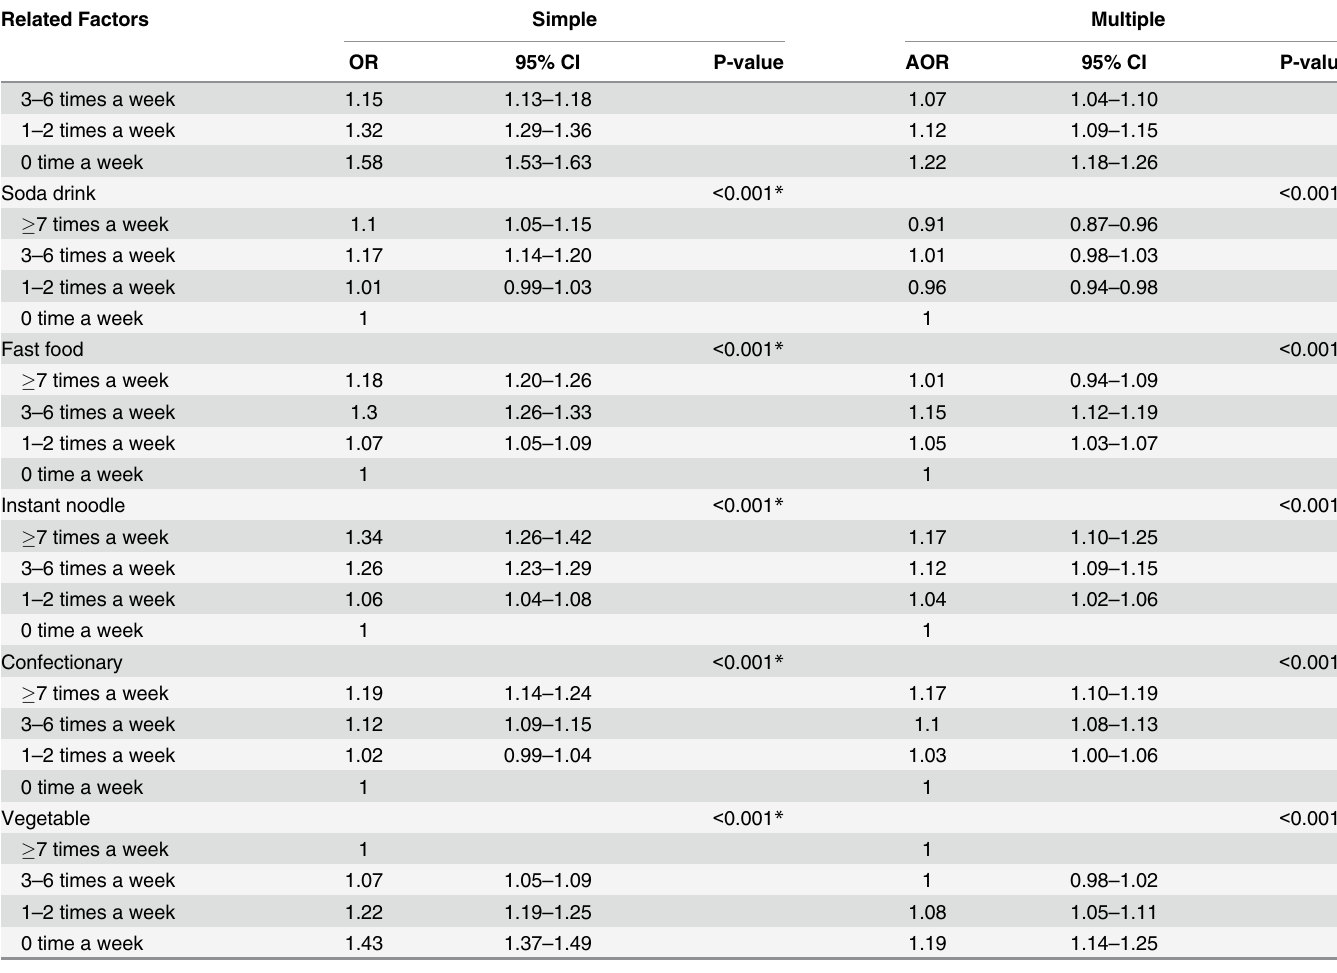
Alcohol and smoking did not show significant associations with halitosis. The relation between soda consumption and halitosis was inconsistent. Compared to the no soda group, the OR of soda consumption (cid:1) 7 times per week was 0.91 (95% CI = 0.87 – 0.96, P < 0.001); how- ever, the OR of soda intake 3 – 6 times per week was 1.01 (95% CI = 0.94 – 0.98, P < 0.001). Fre- quent intake of fast food was associated with halitosis (AOR = 1.15, 95% CI = 1.12 – 1.19, P < 0.001); however, fast food intake more than 7 times per week did not a show significant correlation with halitosis. Instant noodle and confection consumption showed a positive corre- lation with halitosis (AOR = 1.17, 95% CI = 1.10 – 1.25, P < 0.001). In contrast, fruit intake showed a negative correlation with halitosis (AOR = 1.22, 95% CI = 1.18 – 1.26, P < 0.001 for 0 times per week compared to (cid:1) 7 times per week). Vegetable intake also showed a negative cor- relation with halitosis (AOR = 1.19, 95% CI = 1.14 – 1.25, P < 0.001 for 0 times per week com- pared to (cid:1) 7 times per week) but lost significant correlation when eaten more than 3 times per